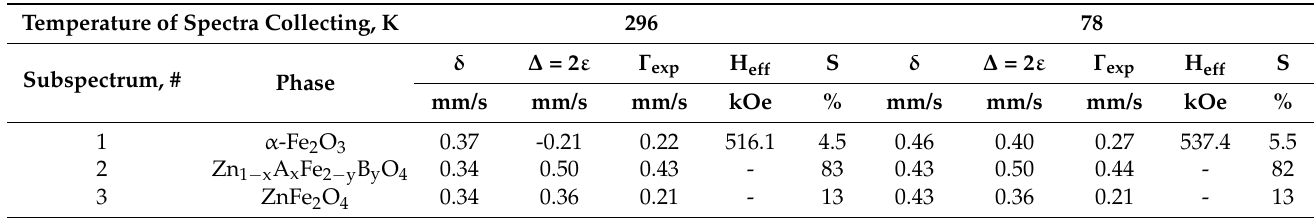
Table 5. Parameters 1 of the Mössbauer spectra of the ZPR sample.